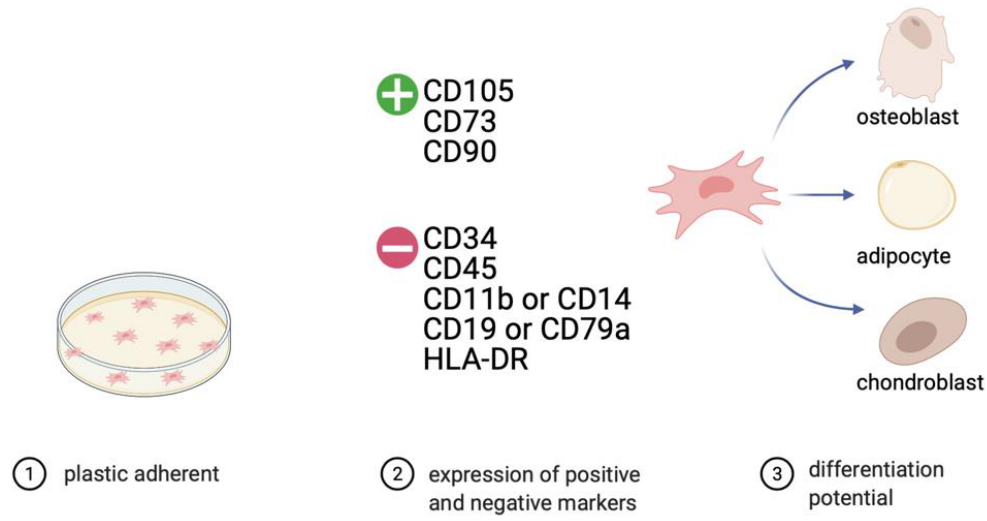
Figure 2. Minimal criteria for defining multipotent mesenchymal stem cells, according to the International Society for Cellular Therapy (ISCT). (Figure created with https://biorender.com, accessed on 21 March 2021). (1) MSCs must be plastic adherent in standard culture conditions. (2) Expression of CD73, CD90, CD105, and absence of the expression of hematopoietic cell surface markers CD34, CD45, CD11b or CD14, CD19 or CD79a, and HLA-DR. (3) Upon specific stimulation, MSCs must differentiate into osteoblasts, adipocytes, or